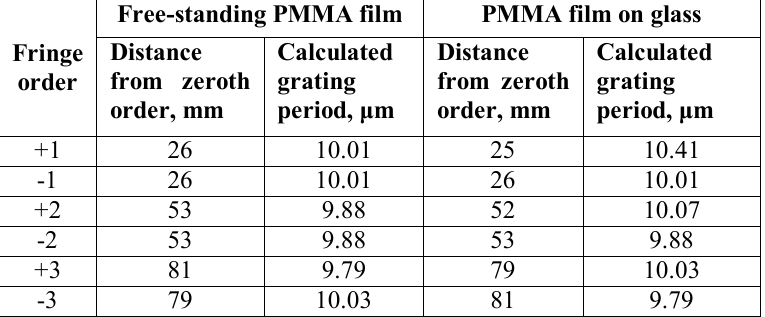
Table 2. The period of the diffraction gratings calculated from the interference pattern.